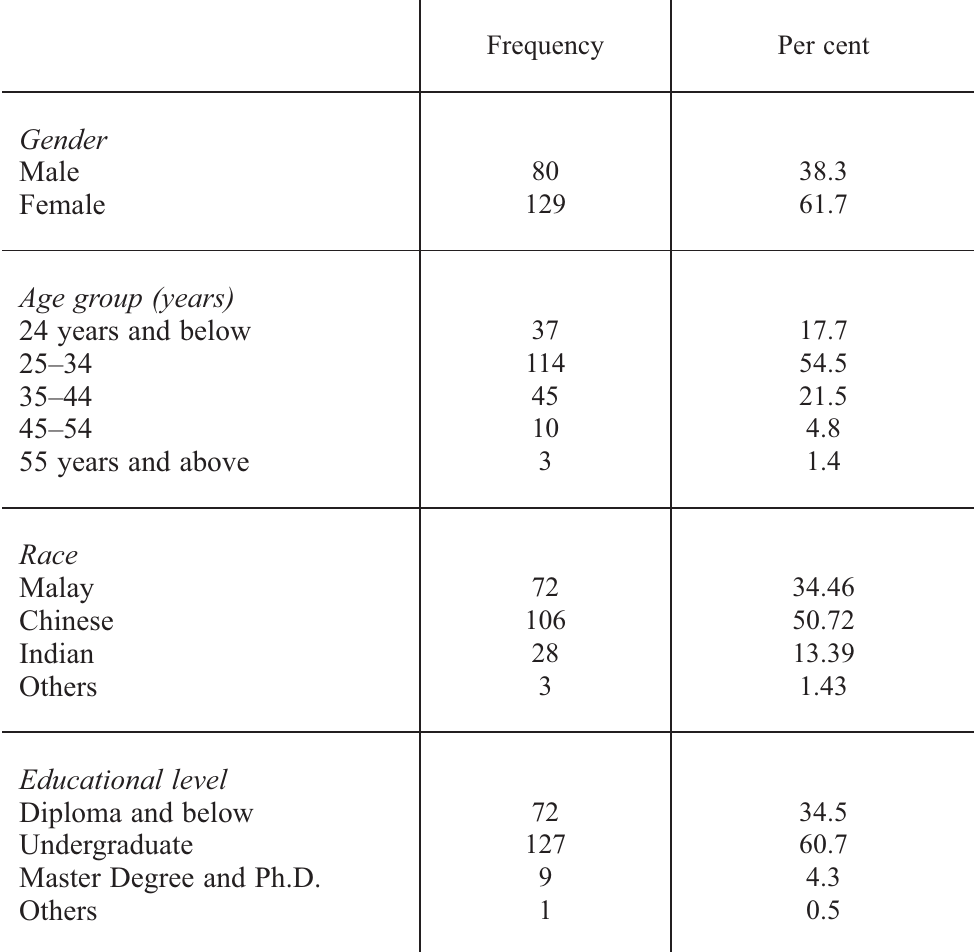
Table 1. Demographic background of the